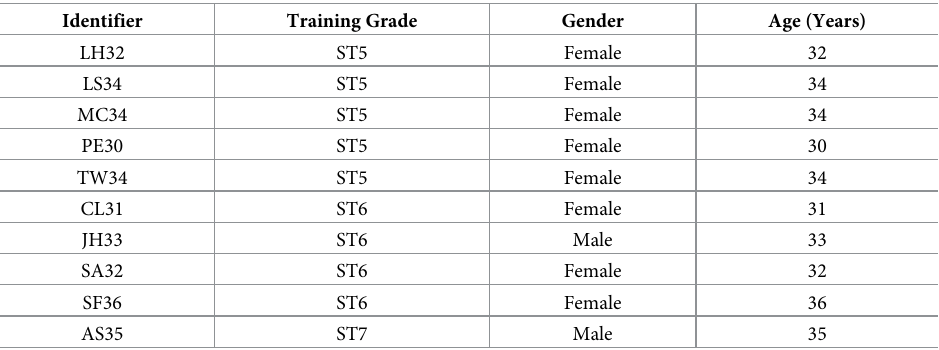
Table 1. Participant